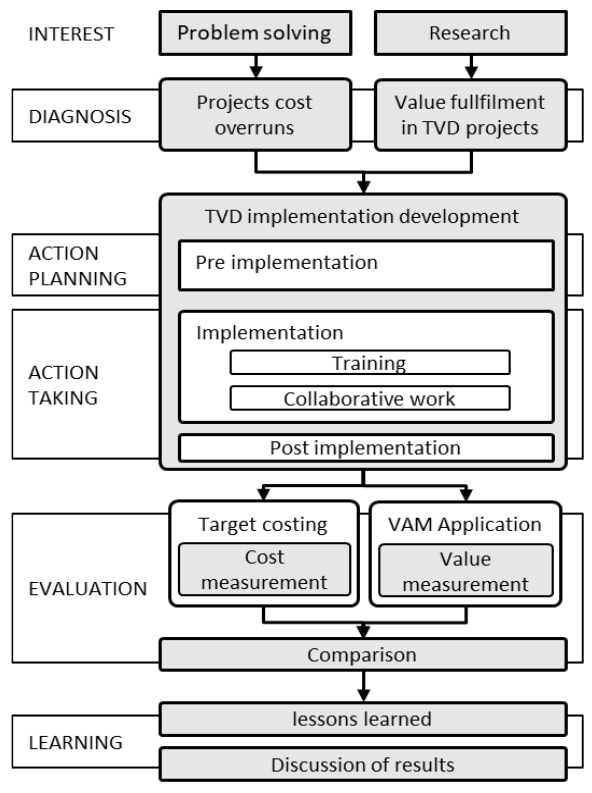
Figure 3. Research